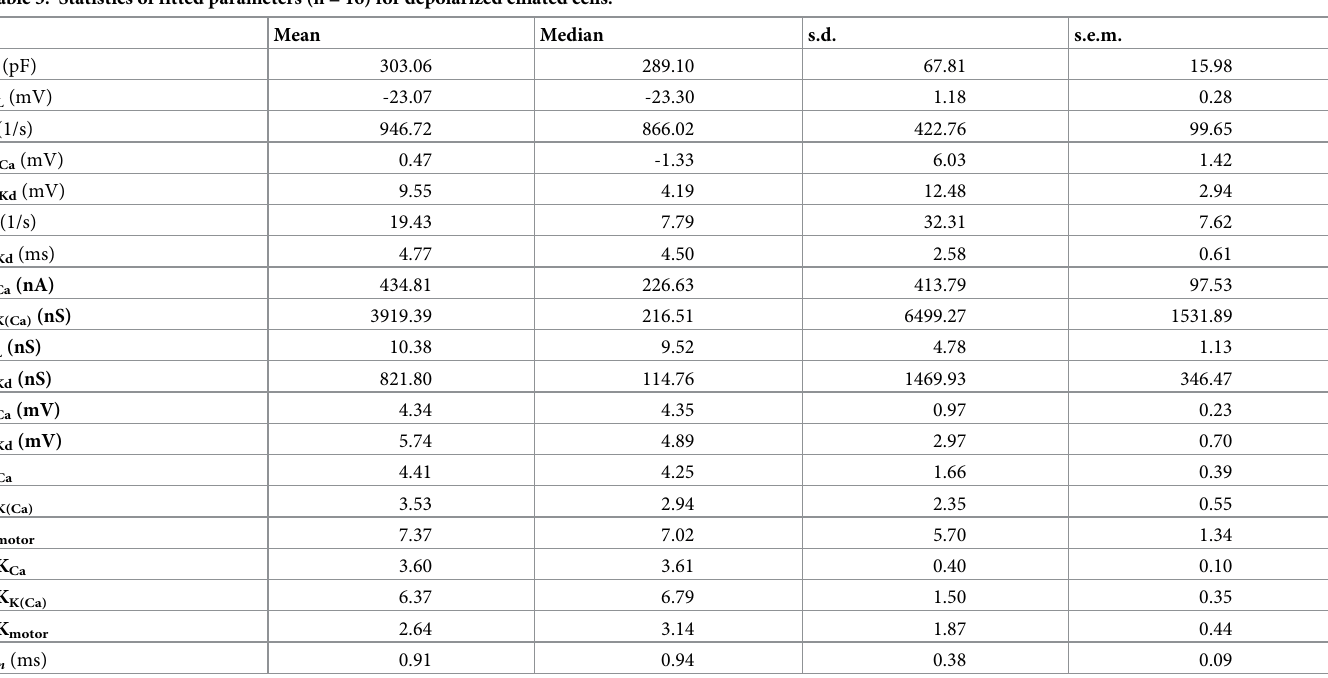
Table 3. Statistics of fitted parameters (n = 16) for depolarized ciliated cells. Mean